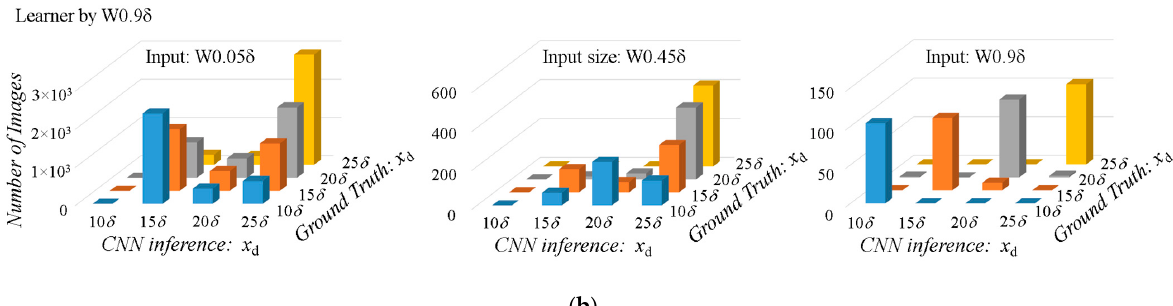
Figure 9. Prediction accuracy with mismatch in the window size between the learner and test input images. ( a ) Learner of W0.05 δ ; ( b ) learner of W0.9 δ , which, of course, provides a good performance when the window sizes are matched between the training image (the learner) and testing image.